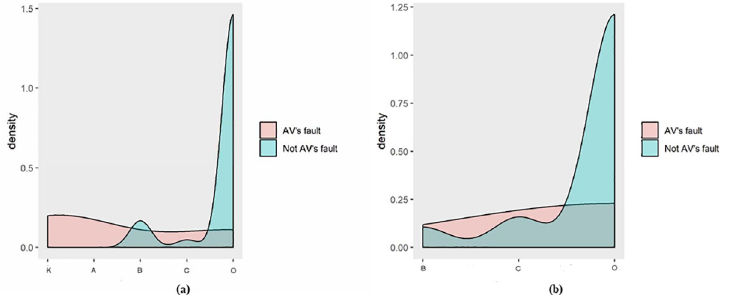
Fig 1. Densities of each level of crash severity in (a) AD mode; (b) Conventional mode.